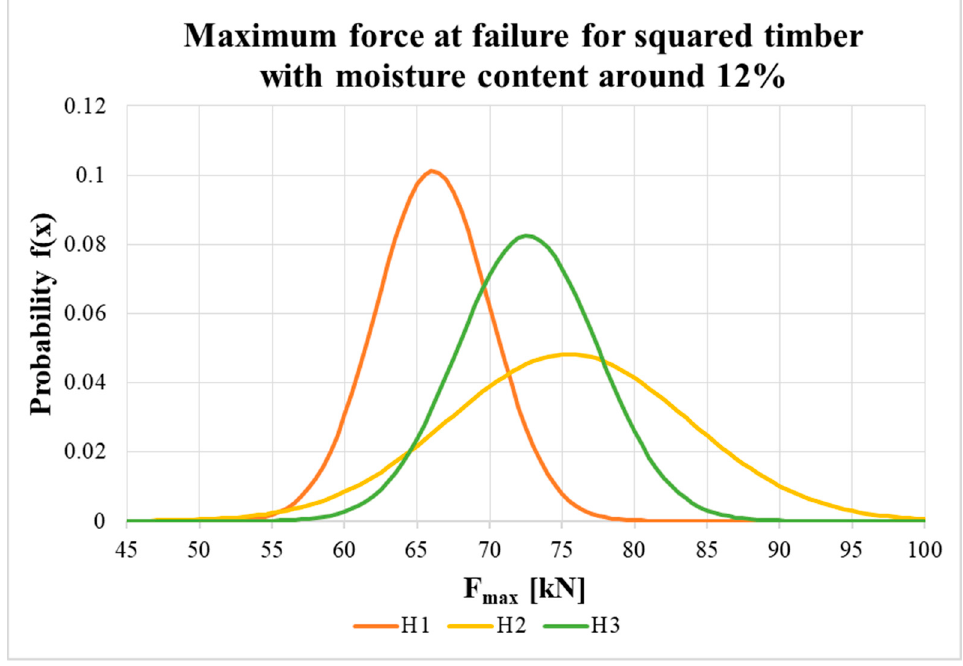
Figure 15. Probability density function of maximum force at failure for H1, H2 and H3.